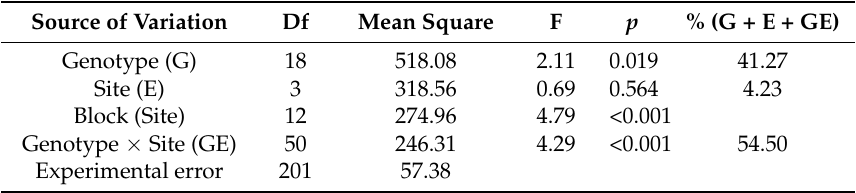
Table 4. Results of the analysis of variance for tree heights for 19 populations at four experimental sites, along with the percentage of the variation explained (F statistics for genotype and site effects are calculated according to Hocking’s approach).